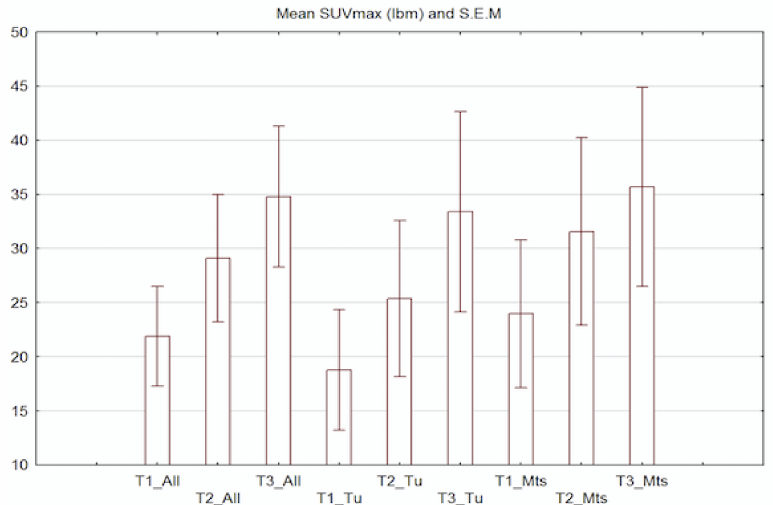
Figure 1. The summarized results of the mean value of SUVmax (lbm) in data sets from three acquisitions (T1—early 1.0–1.5h, T2—3.0–4.0 h and late T3—6.0–7.0 h) in selected patients with active disease including the mean value of SUVmax (lbm) for all detected and selected lesions (T1–T3_All), in those patients with the presence of prostate tumors (T1–T3_Tu) and in those subjects with metastatic disease including lymph nodes involvement and bone metastasis (T1–T3_Mts).